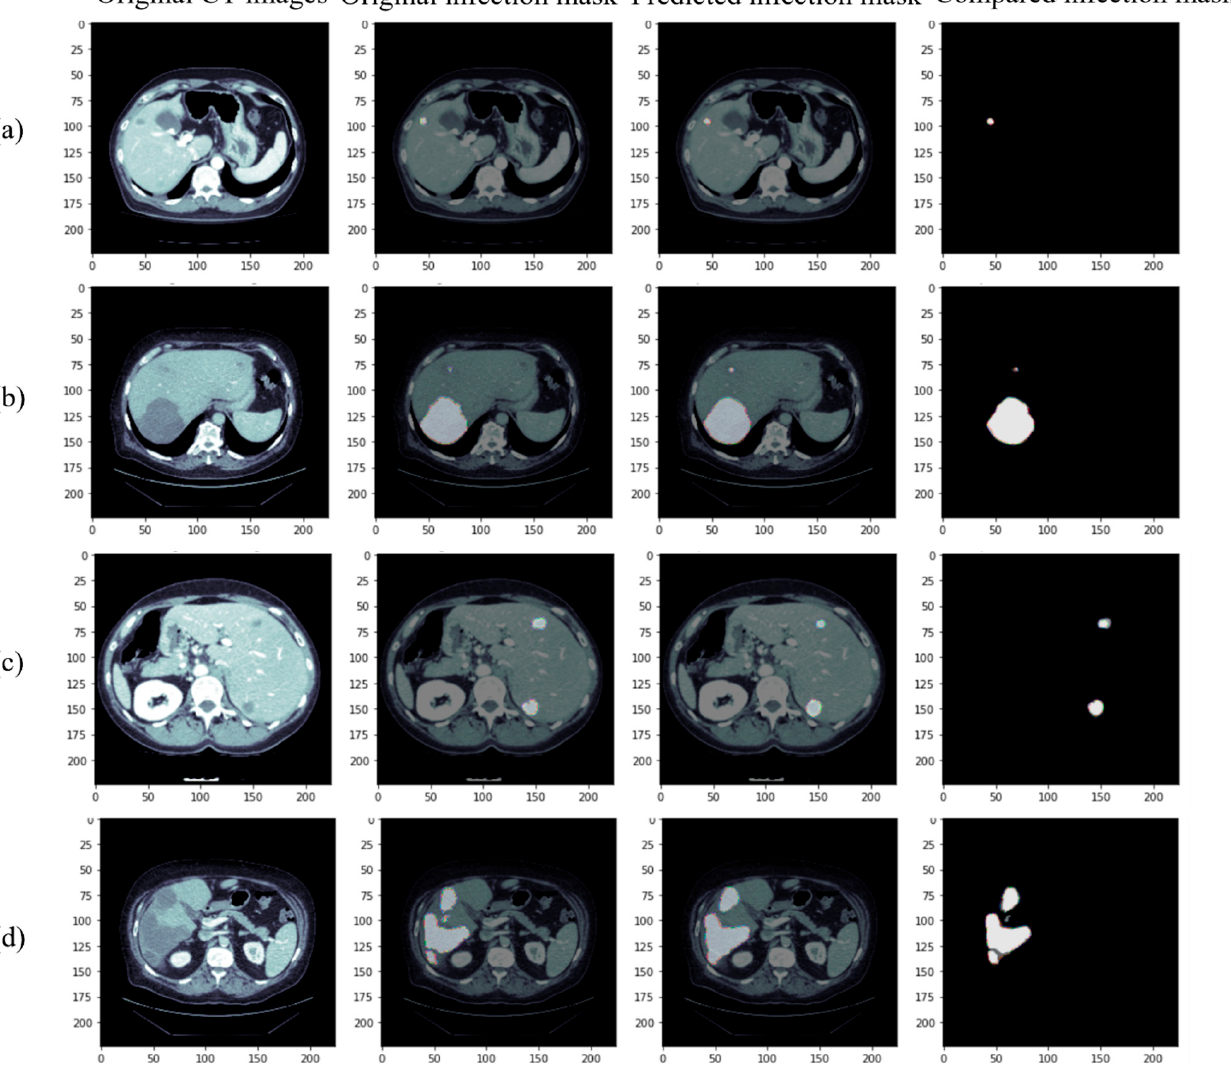
Figure 7. Segmentation results of our proposed model for the lesion: ( a ) small tumor ( b ) large tumor (with small tumor) ( c ) multiple small tumors ( d ) multiple large tumors (from left to right, original CT image, Ground Truth, predicted results of our proposed model, and superposition of Ground Truth and predicted results).